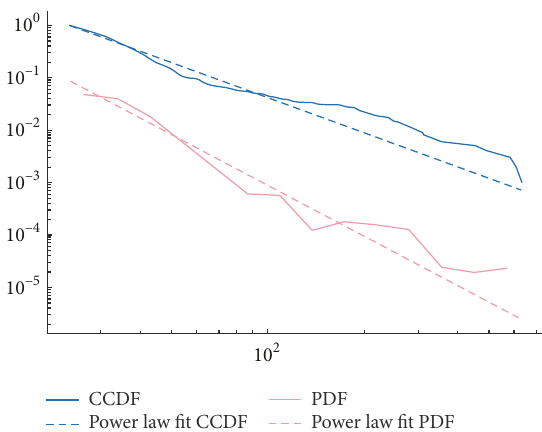
Figure 3: PDF and CCDF for empirical time series 𝑀𝑃 𝑡 .